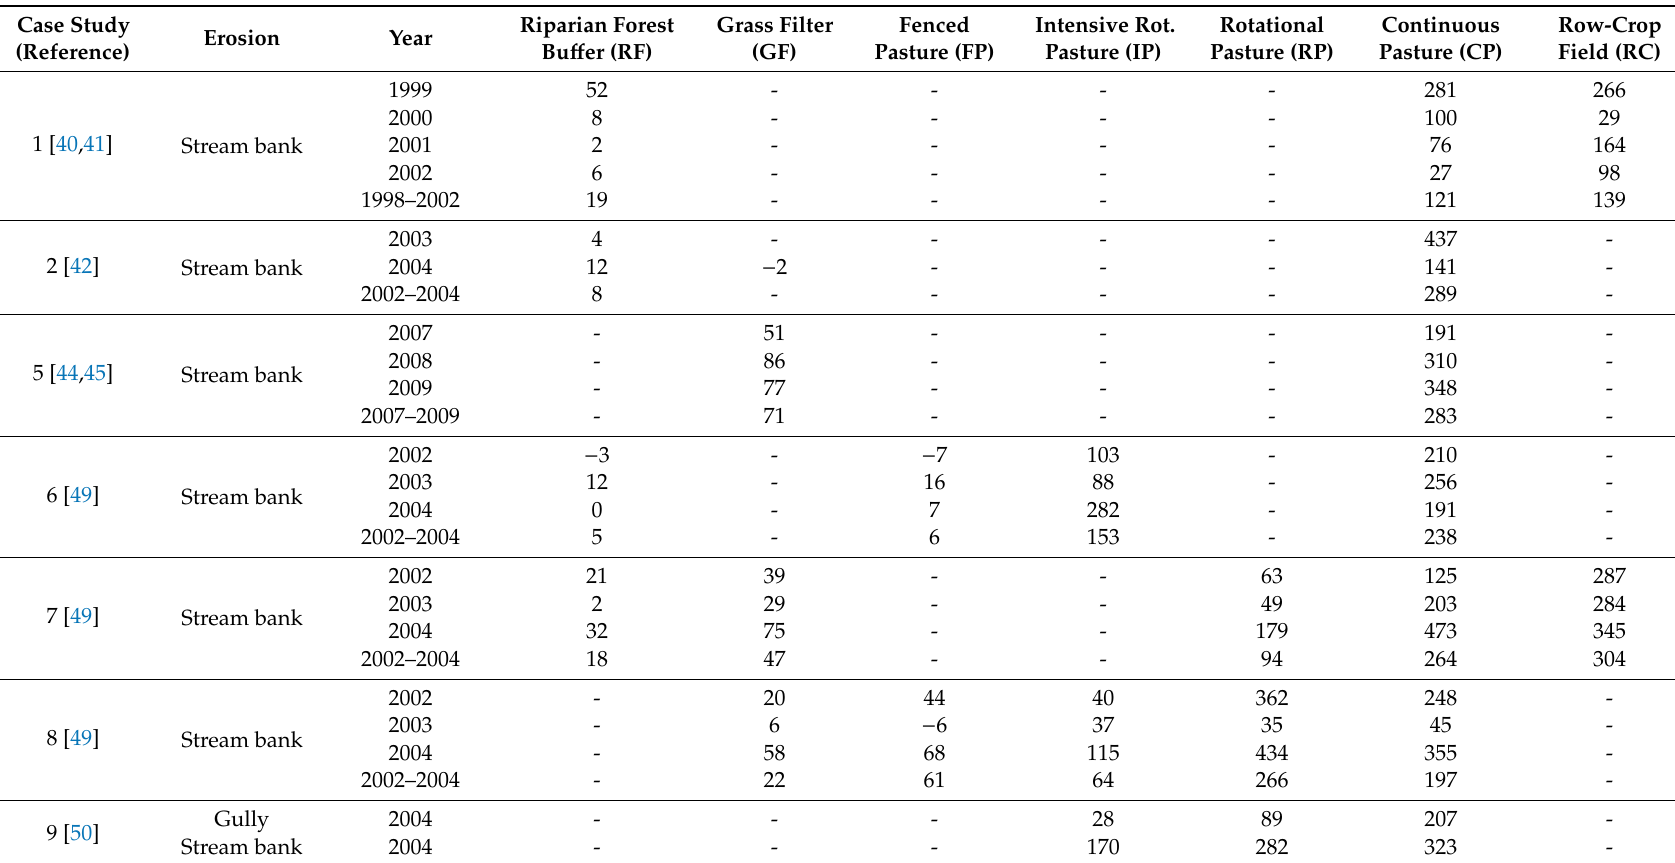
Table 4. The stream bank soil losses per stream length (Mg km − 1 year − 1 ) and gully bank soil losses per gully length (Mg km − 1 year − 1 ) of di ff erent riparian land-uses from di ff erent case-studies conducted in